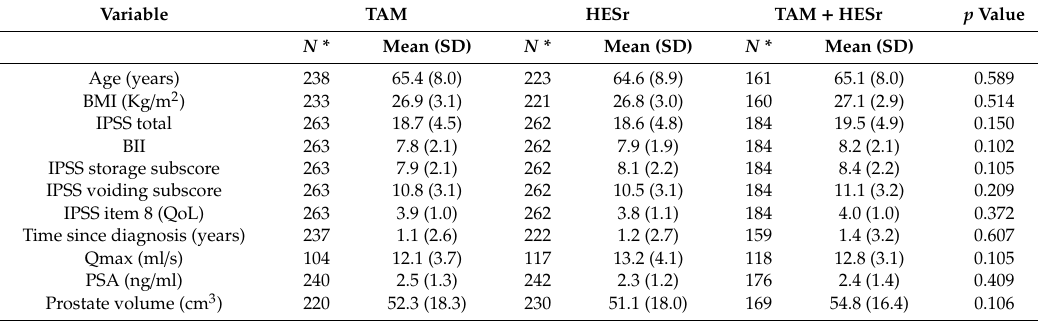
Table 1. Patient characteristics at baseline for the three study groups (ITT analysis).